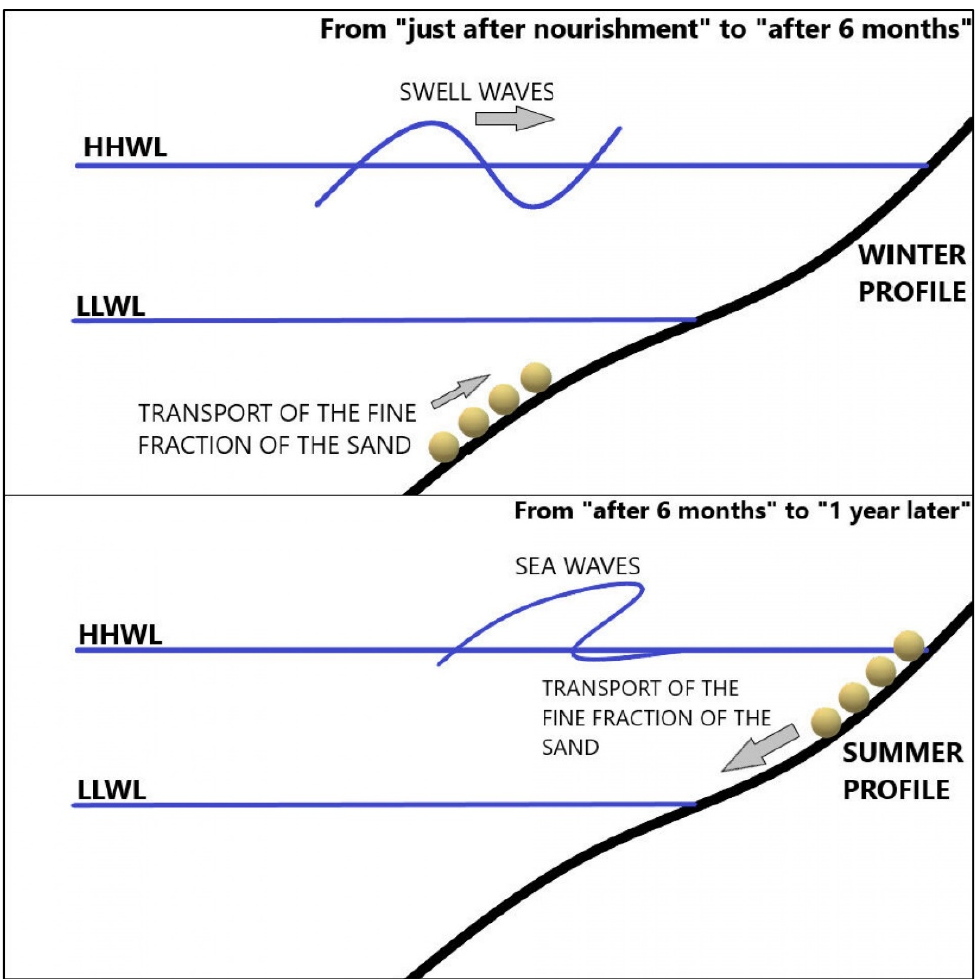
Figure 8. Sketch showing the upwards movement of the fine fraction of the sand by swell waves during the summer season ( top ) and downwards due to sea waves during the winter season ( bottom ).